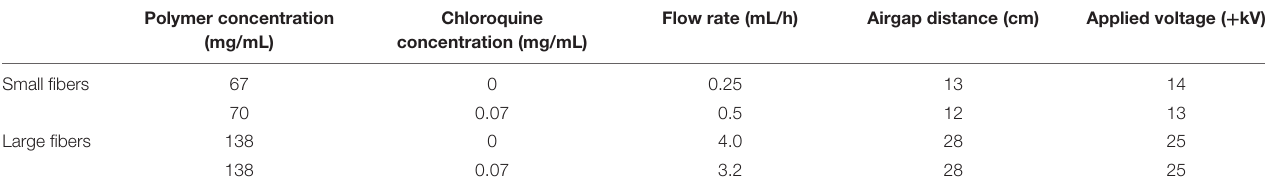
TABLE 1 | Electrospun biomaterials were fabricated with optimized parameters. Polymer concentration Chloroquine (mg/mL) concentration